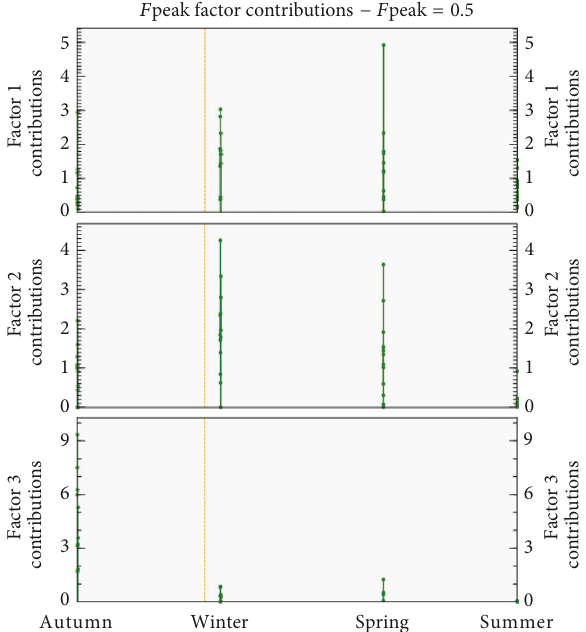
Figure 7: Seasonal contributions of PMF factor